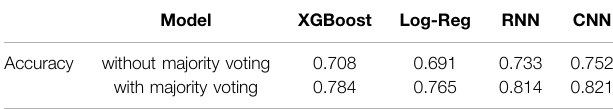
TABLE 1 | Accuracy of different machine learning models on the task of inferring gender from